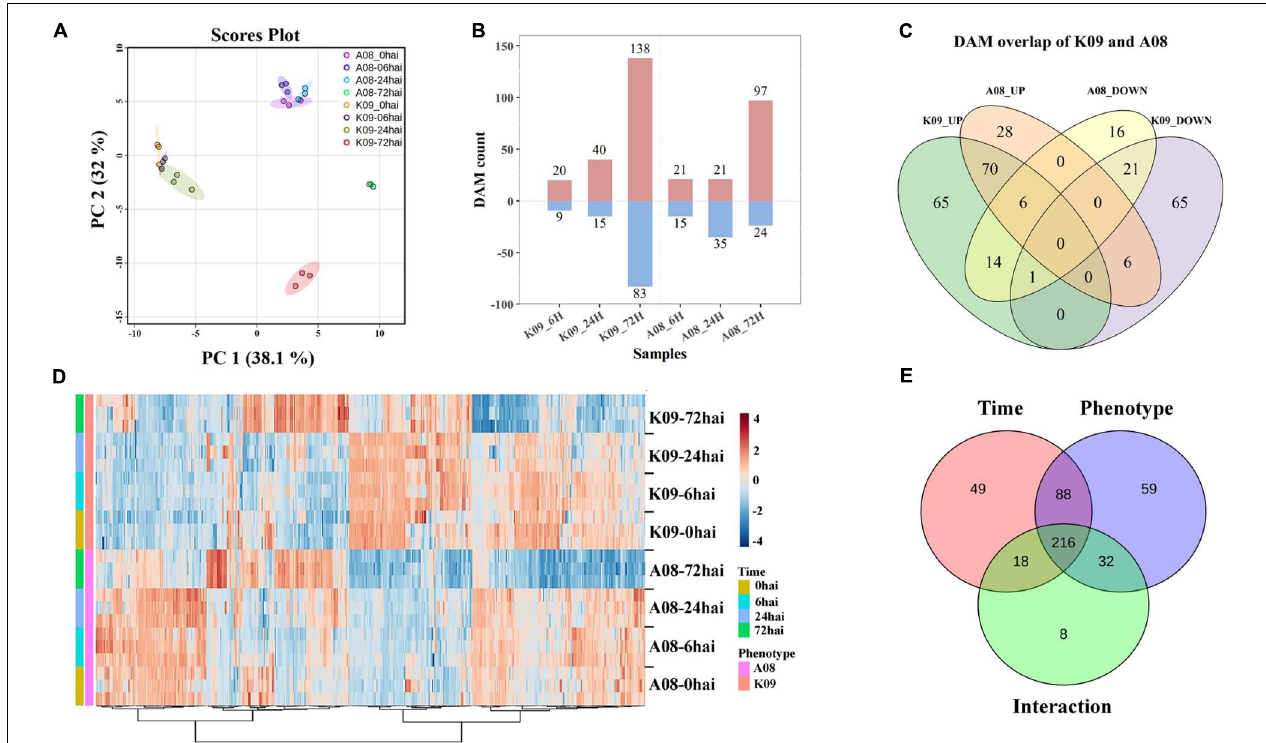
FIGURE 9 | Metabolomic analysis of K09 and A08 stems at different time points upon infection with F. graminearum . (A) PCA score plot based on the metabolite profiling of K09 and A08. (B) The total number of up- and down-regulated differentially accumulated metabolites (DAMs) identified at different time points in K09 and A08. (C) Venn diagram illustrating the unique and common DAMs between K09 and A08. (D) Heatmap of DAMs identified to be significantly discriminatory between K09 and A08 upon infection with F. graminearum . The side bars on the left of heatmap represent genotypes and time points, respectively. The statistical significance was analyzed by two-way ANOVA (interaction p ≤ 0.01). (E) The summary of the number of DAMs discriminated by time points, phenotypes, and interaction between time points and